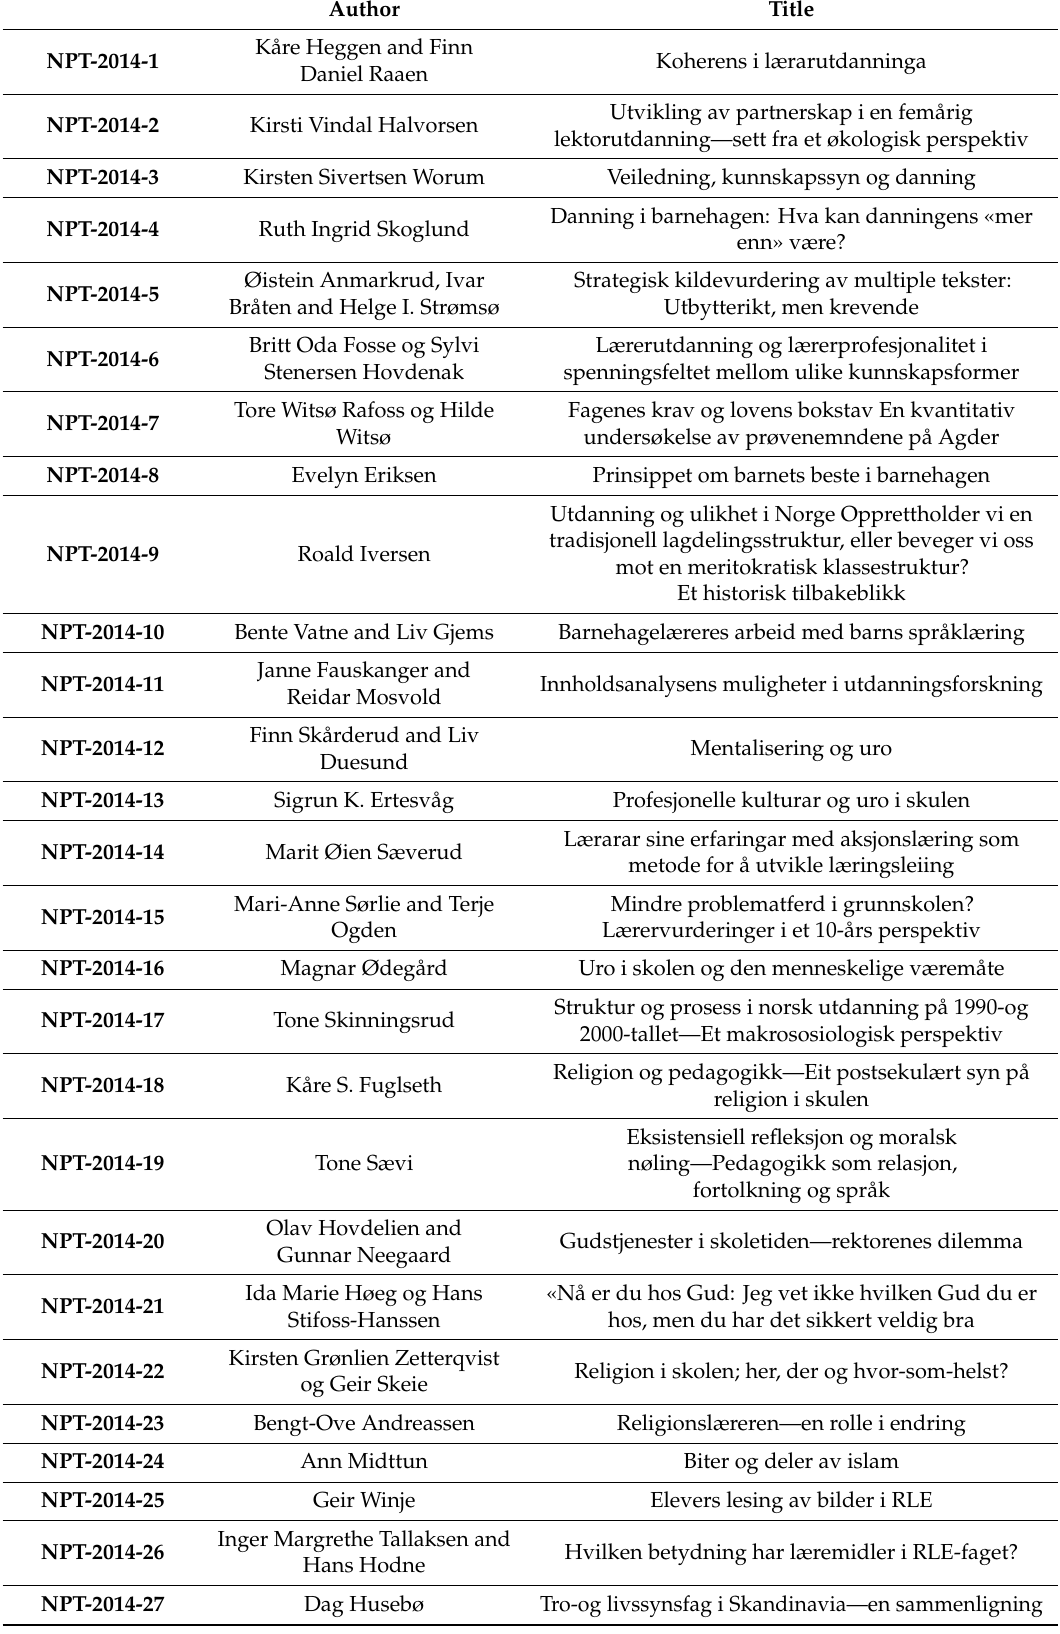
Table A2. Norsk pedagogisk tidsskrift